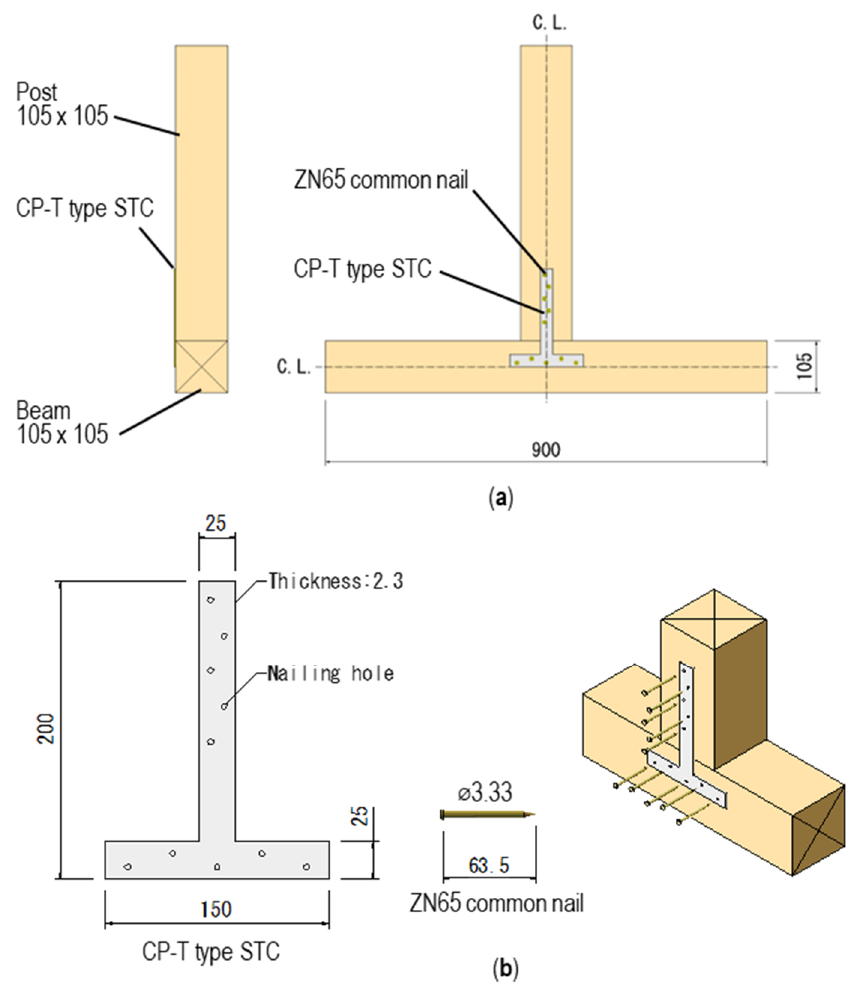
Figure 5. CP-T-type pullout test specimen: ( a ) details of the specimen; ( b ) details of the CP-T-type STC; dimensions in mm.